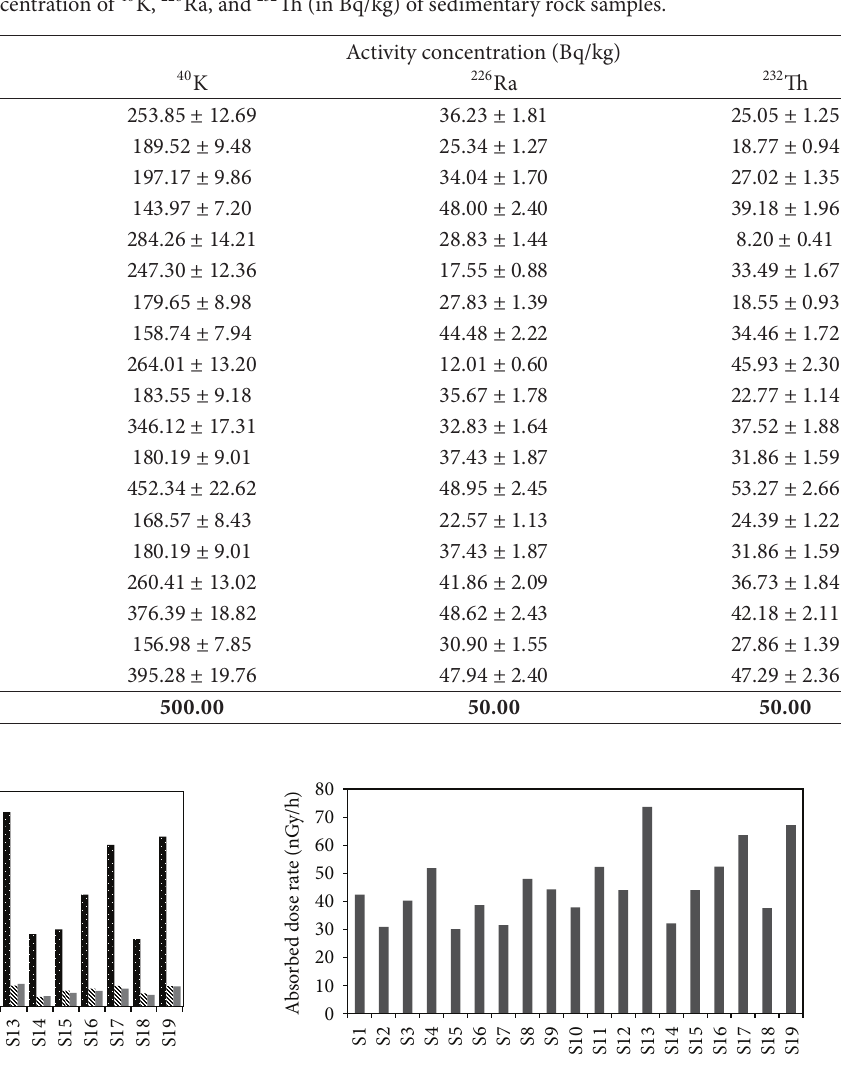
Figure 4: Gamma absorbed dose rate at 1m above ground for all